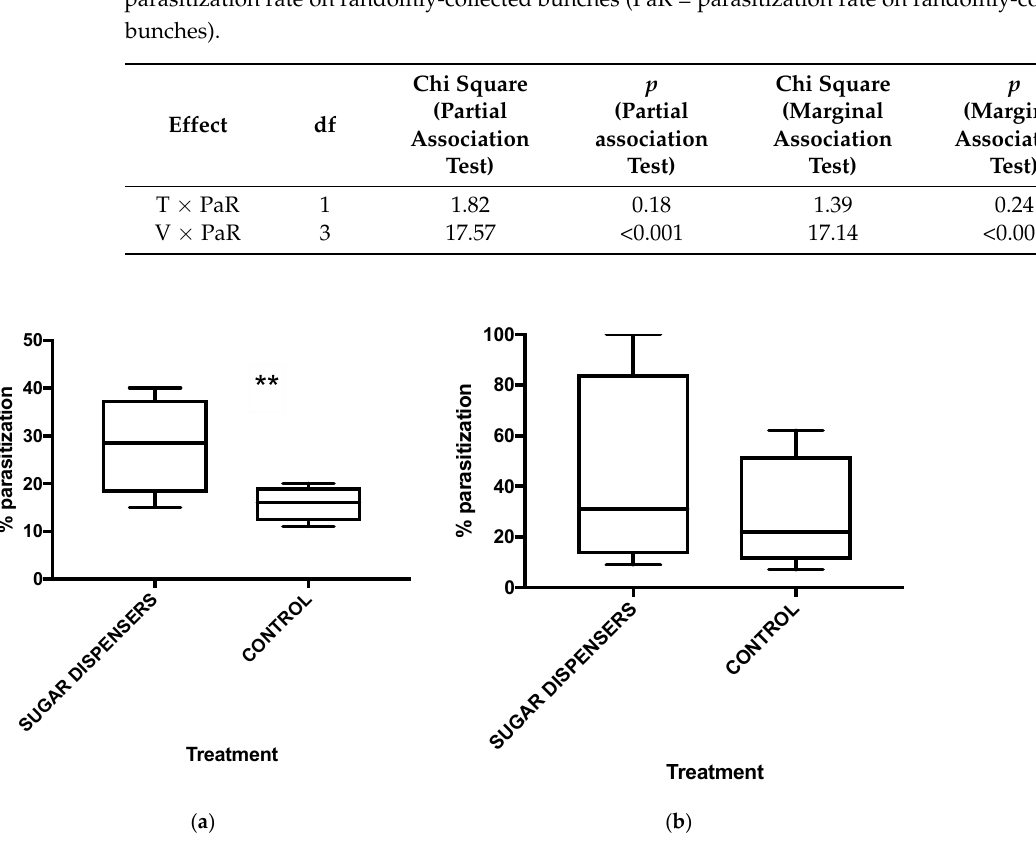
Table 4. Log linear results showing the effect of each factor (T = treatment; V = vineyard) on col- ony parasitization rate (PaC = parasitization rate on colonies).